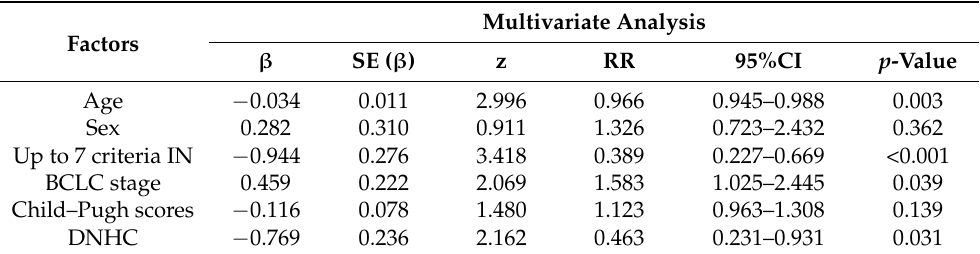
Table 4. Cox proportional hazards regression analysis of factors that were associated with OS in higher-stage HCC.